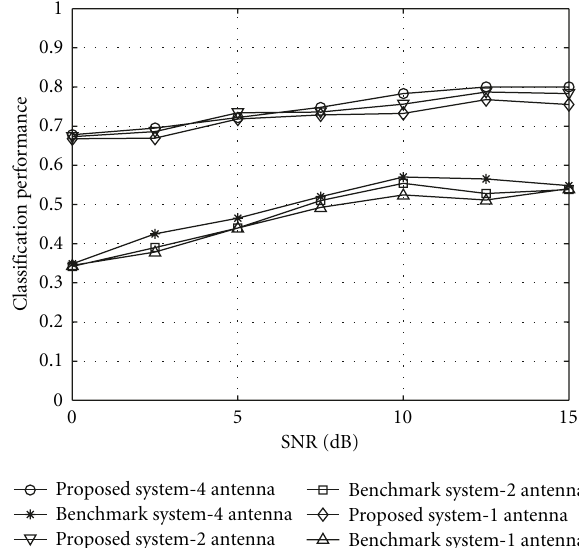
Figure 19: Classification performance of proposed initial SOF- based classification stage and benchmark in a faster varying 20-path fading channel using the MRC-variant combining scheme.